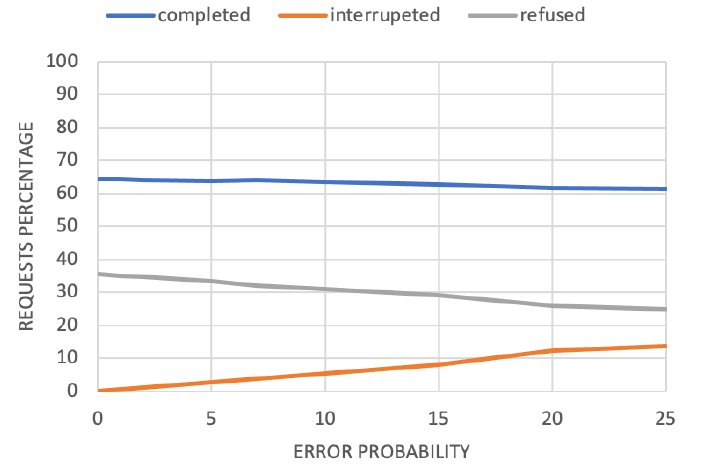
Figure 5. Percentage of completed, interrupted, and refused requests in the trustworthiness-based scenario after 500 time units with 25% request probability as the error probability changes.